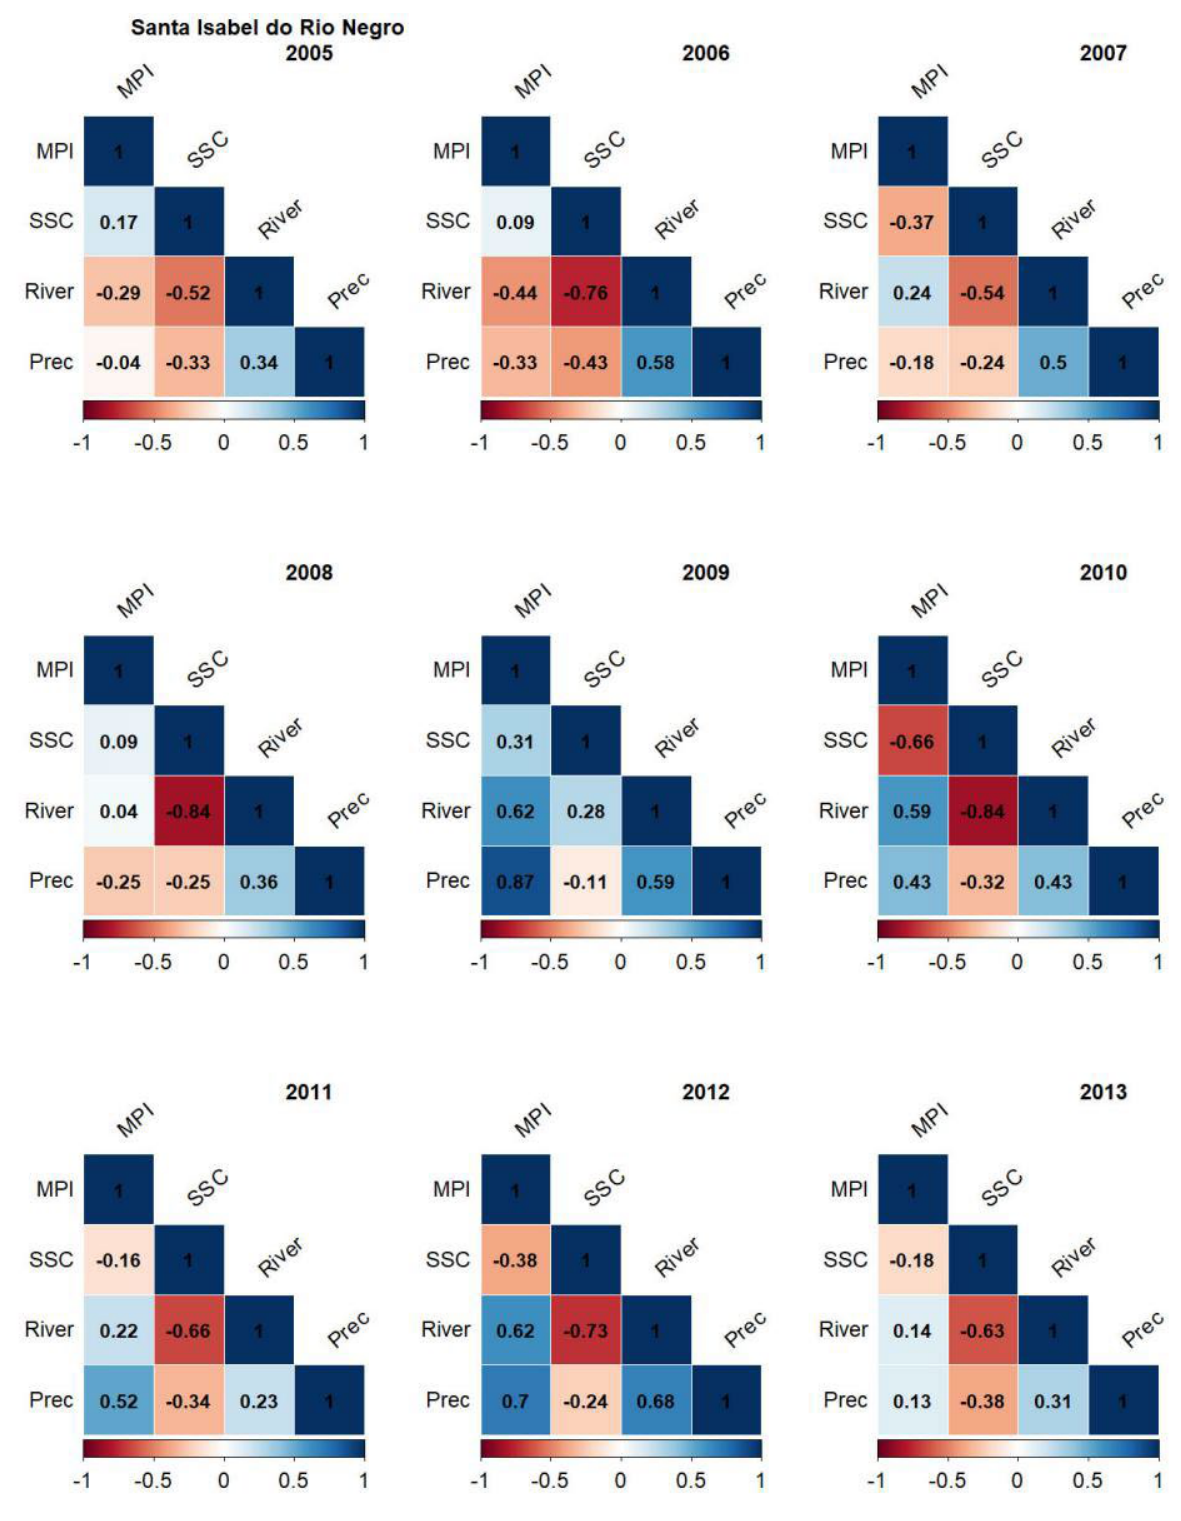
Figure 6. For the municipality of Santa Isabel do Rio Negro, the relationship between monthly malaria parasite index (MPI), of suspended sediment concentration in rivers (SSC), river level (River), and precipitation (Prec), during the period 2005–2013.